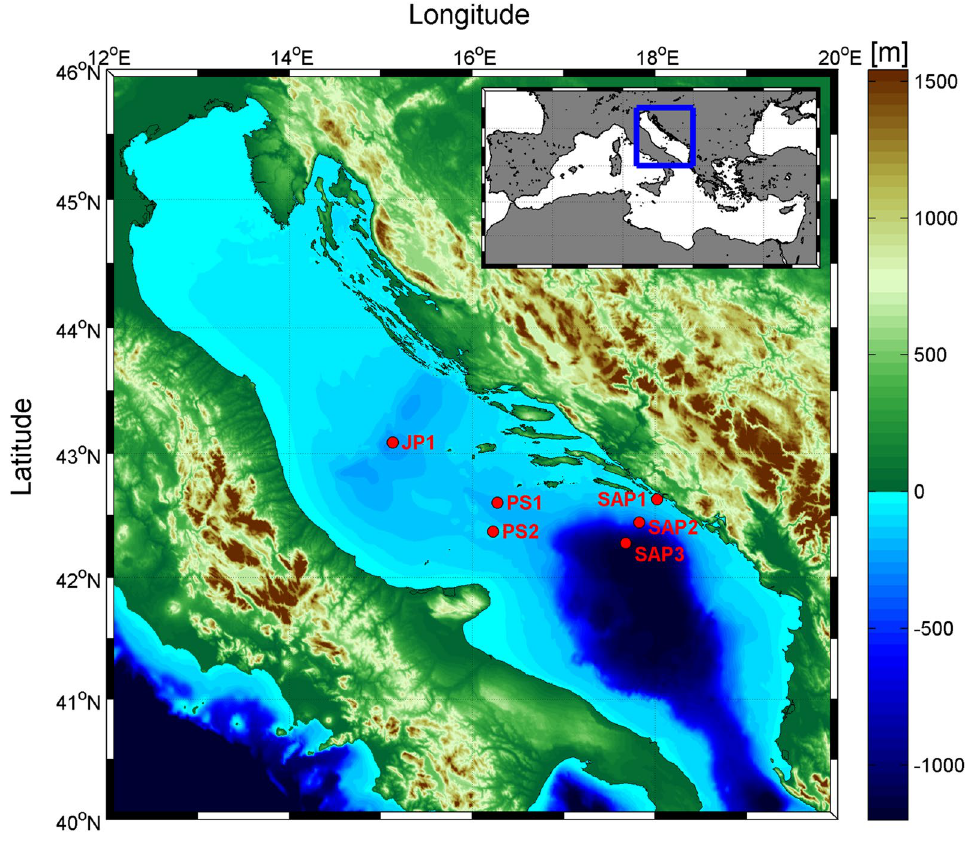
Figure 1. ( A ) Map of the Mediterranean Sea. ( B ) Study area and sampling stations in the Jabuka Pit (JP1), the Palagruža Sill (PS1, PS2) and the South Adriatic Pit (SAP1, SAP2, SAP3). The software MATLAB. version 7.10.0 (R2018). Natick, Massachusetts: The MathWorks Inc. (2018) (https:// www. mathw orks. com/) was used to generate the